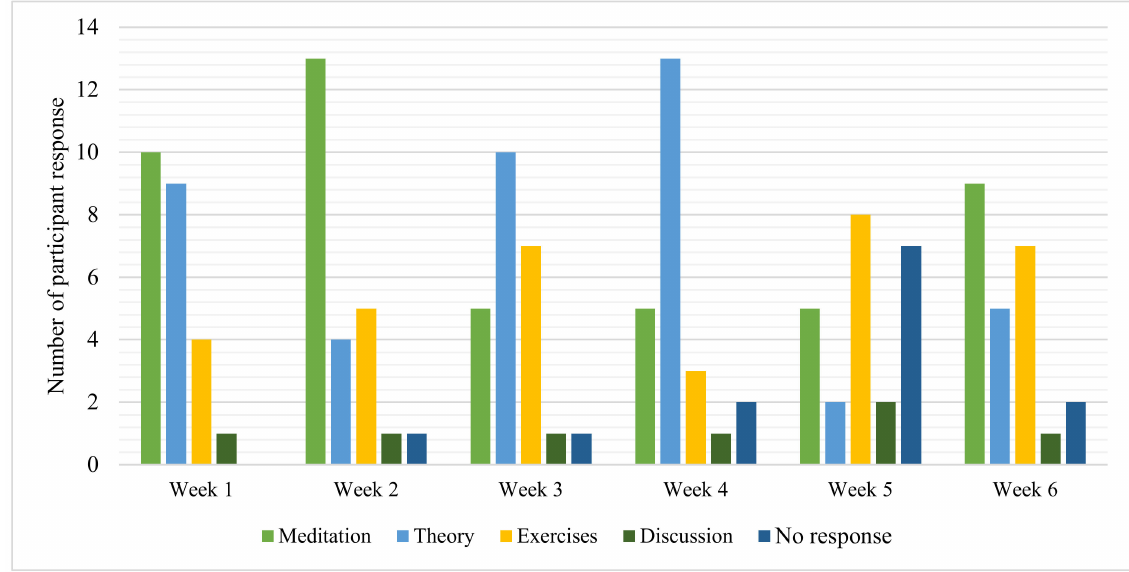
Figure 6. Useful session activities ( n =